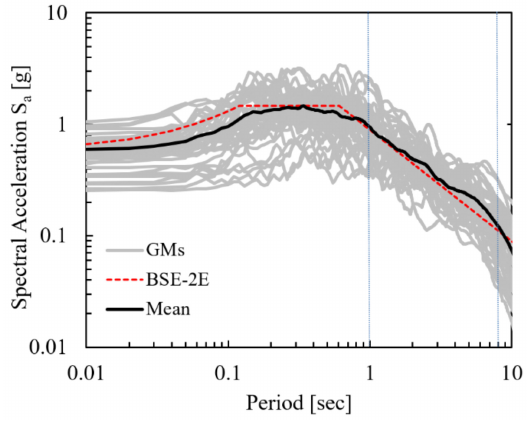
Figure 3. 5% damped response spectra of selected and scaled ground motions in comparison with ASCE-41-13 target spectrum for two-dimensional analyses; BSE-2E level.